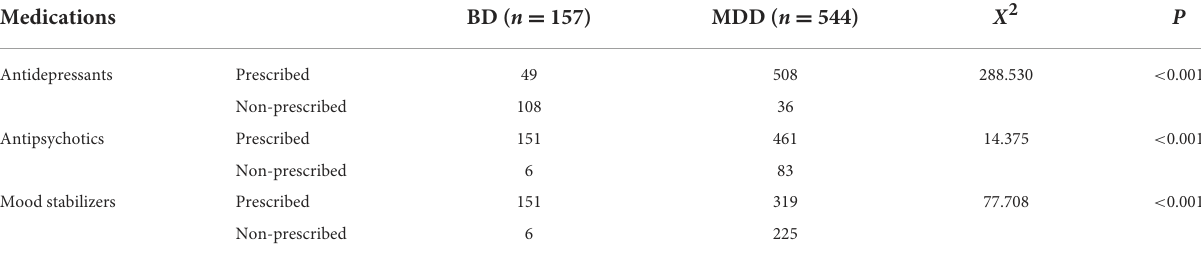
TABLE 1 Medication information of BD and MDD groups.